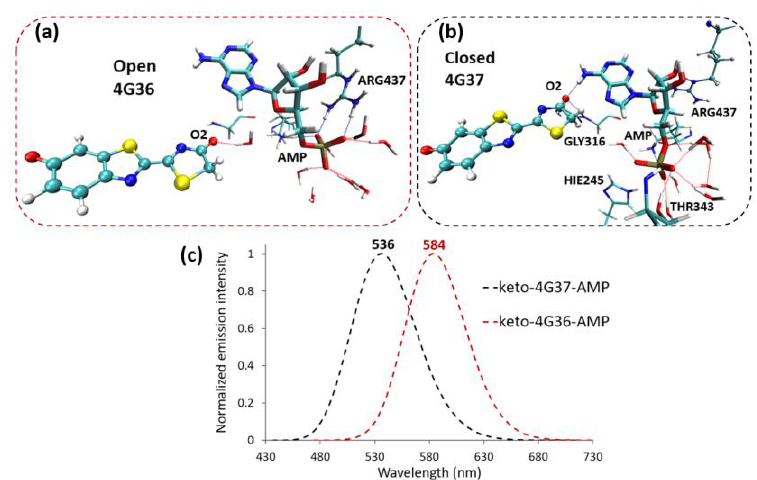
Figure 4. Graphical representation of the hydrogen-bond patterns found along the simulations of ( a ) keto-4G36-AMP and ( b ) keto-4G37-AMP. ( c ) Simulated emission spectra for keto-4G36-AMP and